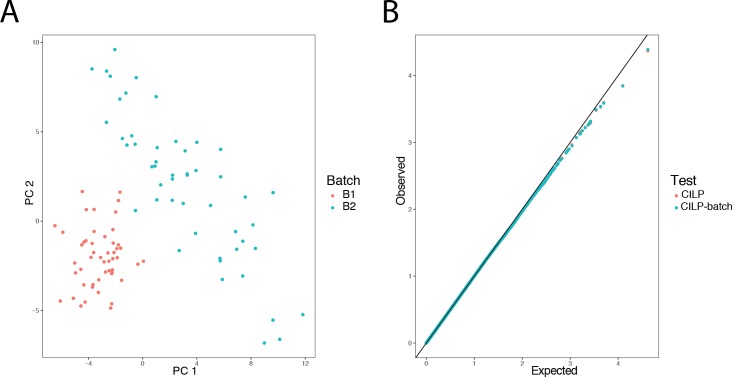
Simulated batch effects on transcriptional correlation structure do not produce false positive correlation QTLs.500 genes were simulated in 100 individuals over two batches, with no covariance between genes in batch 1, and a covariance of 0.3 among all pairs of genes in batch 2. Panel A presents a PCA on the simulated gene expression data, with individuals colored by batch. To assess the false positive rate under the null, a genotype was simulated with no effect, and CILP was applied to estimate the genetic effect on the degree of correlation between each gene pair. Panel B shows that the observed p-values from CILP both when adjusting for batch (by including it as a covariate in a linear model) as well as ignoring batch are not greater than p-values observed under the expected uniform distribution, suggesting that batch effects do not cause inflation or affect the estimation of the genetic effect.